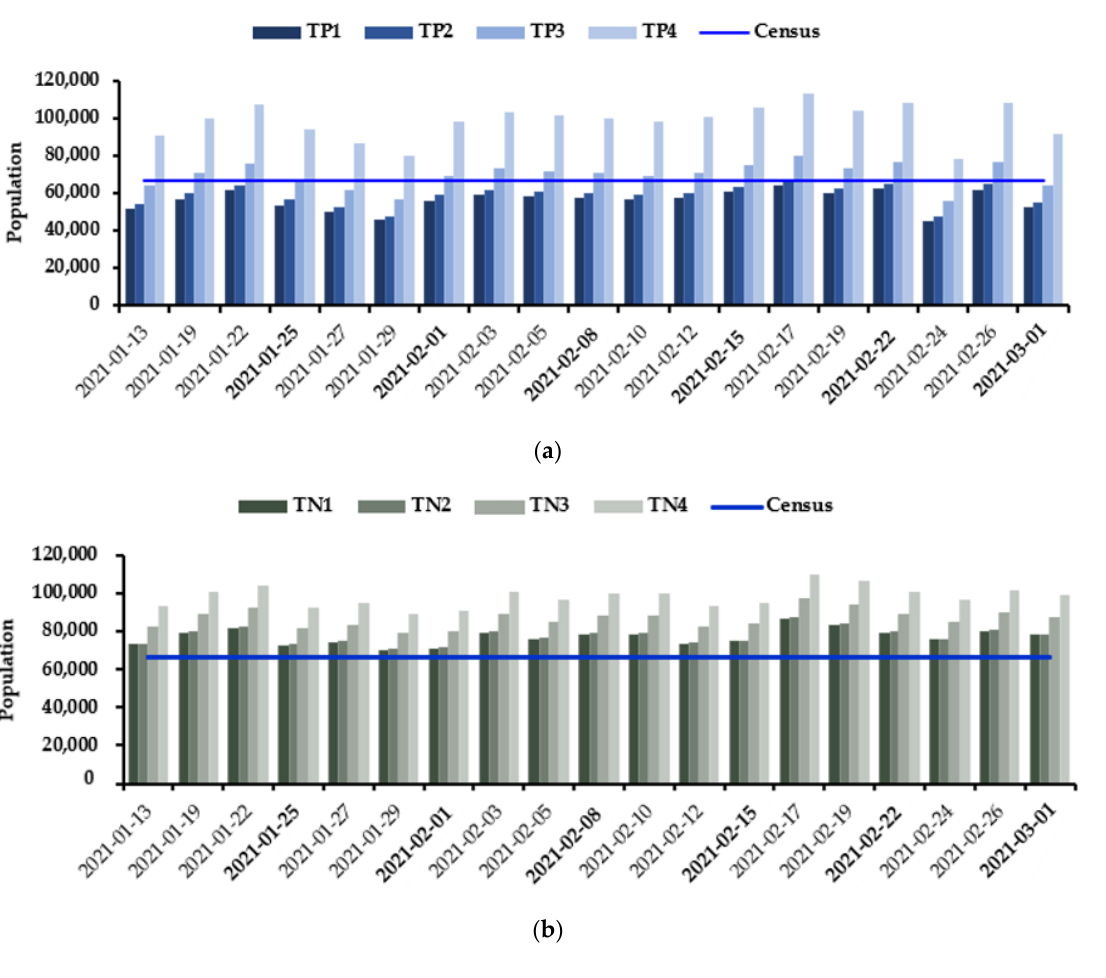
Figure 1. Overview of census and estimated population size at UDD WWTP on the identified sampling dates, wherein population size is estimated using four TP excretion rates ( a ) and four TN excretion rates ( b ) (note: dates in bold indicate 72 h (weekend) samples).